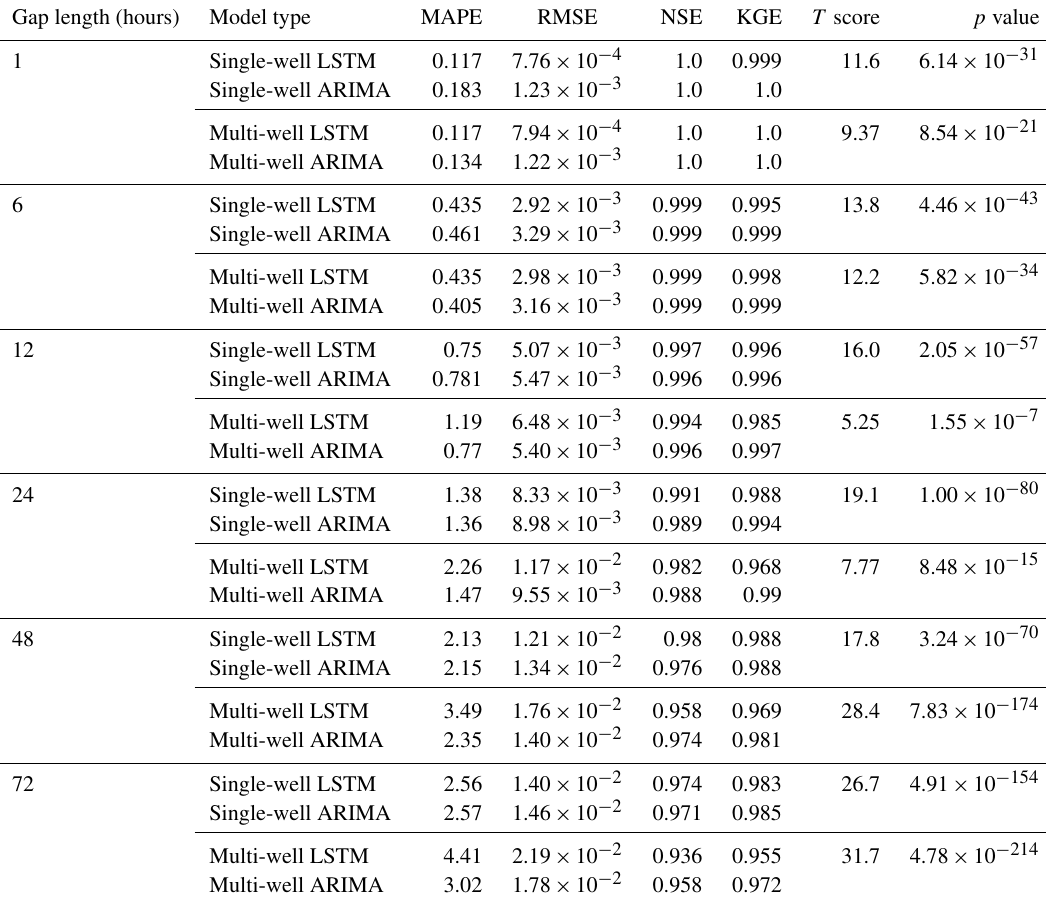
Table 3. Comparison of single-well and multi-well LSTM and ARIMA models for all synthetic gap lengths in the SpC data. The models are the same as those used in Fig. 9. Calculations are performed on the test dataset for well 1-1 (year 2016). The calculated statistics are as follows: the mean absolute percentage error (MAPE), the root-mean-squared error (RMSE), the Nash–Sutcliffe model efficiency coefficient (NSE), and the Kling–Gupta efficiency (KGE). T scores and p values are calculated on the relative errors of the two single-well models for each gap length and calculated on the relative errors of the two multi-well